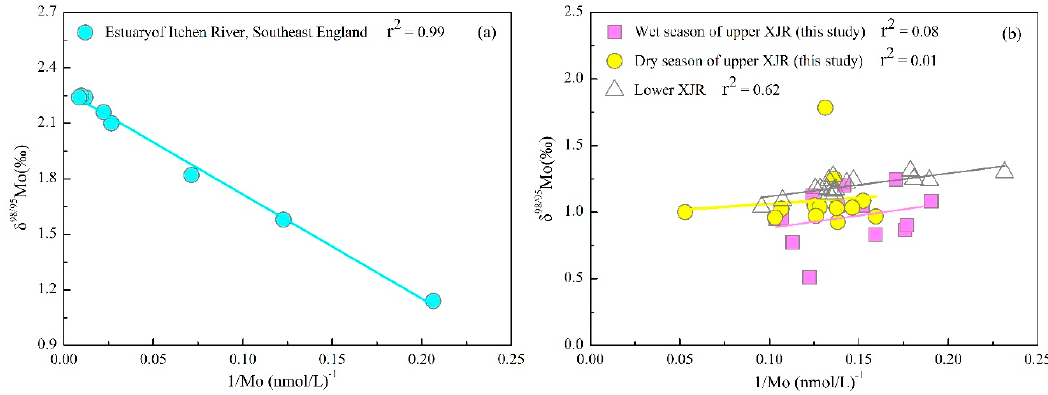
Figure 5. The correlation between δ 98/95 Mo and 1/[Mo], ( a ) the dissolved δ 98/95 Mo in the Itchen estuary versus 1/[Mo] [19]; ( b ) the dissolved δ 98/95 Mo versus 1/[Mo] for upper XJR water (this study) and lower XJR [15].